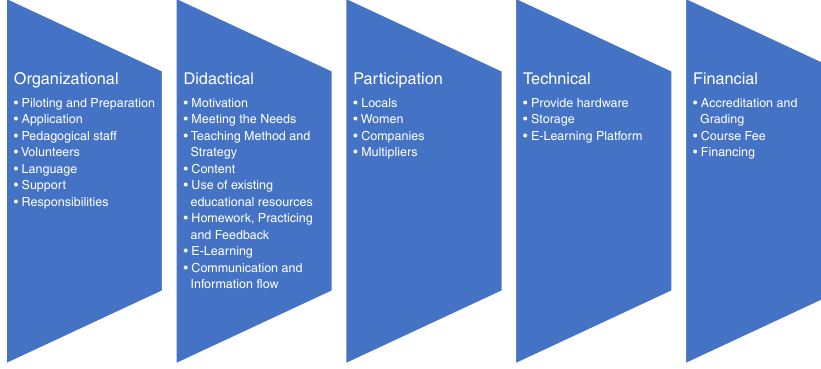
Figure 9. Proposed